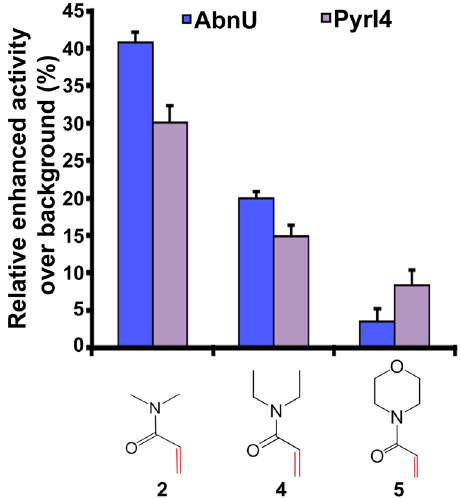
Fig. 7 Substrate scope of AbnU and PyrI4. Substrate selectivity of AbnU and PyrI4 for different dienophiles namely 2 , 4 and 5 combined with diene 1a to yield 3a , 6 and 7 , respectively. Data shown here represent the enzymatically- enhanced activity over the background reaction. All error bars re fl ect the standard deviation obtained from independent triplicate